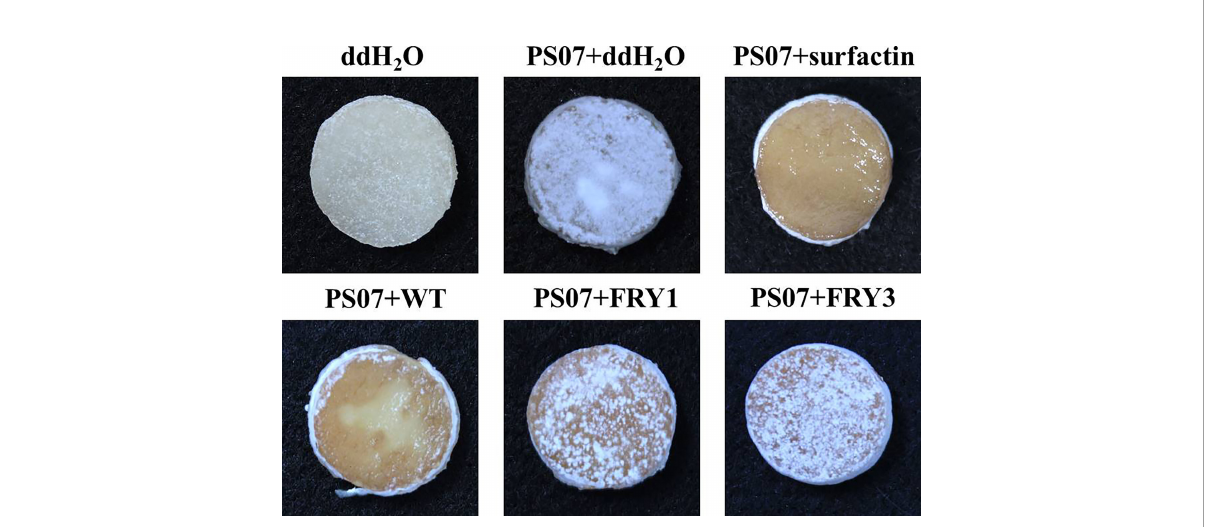
FIGURE 12 Two D srf mutants did not effectively inhibit the growth and sporulation of S. scabies PS07 on potato tuber slices. The 25 m l 10 8 spores/ml of S. scabies PS07 spores were inoculated on potato tuber slices, incubated at 28°C for 1 day in the dark, and then 20 m l of Ba01 WT, FRY1, FRY3 (OD 600 = 1), ddH 2 O or surfactin (0.1 mg/ml) were added to potato tuber slices. The samples were further incubated in the moist chamber at 28°C for 5 days before